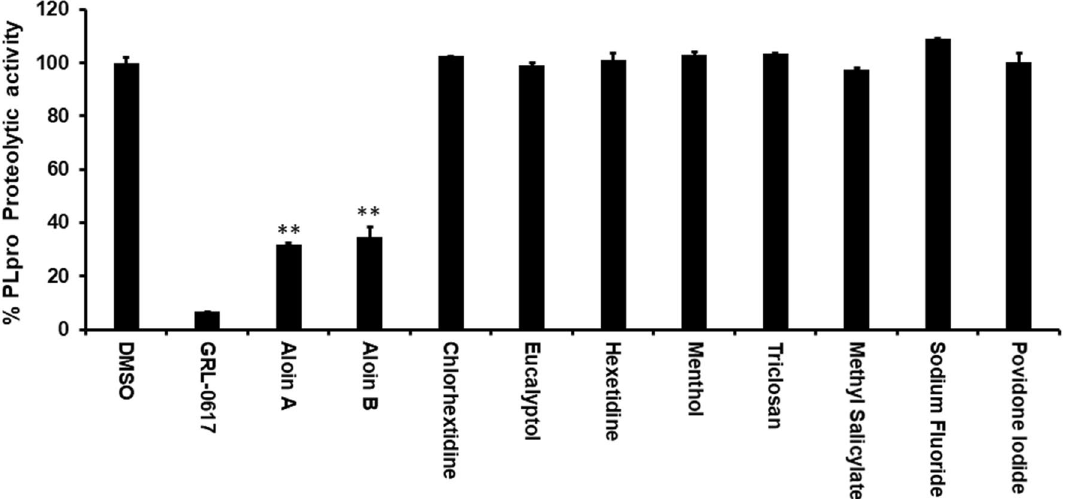
Figure 3. Aloin A and B specifically inhibits the SARS-CoV-2 PLpro proteolytic activity. Aloin A, aloin B, chlorhextidine, ecalyptol, hexetidine, menthol, triclosan, methyl salicylate, sodium fluoride and providone iodide were selected for their inhibitory activity against SARS-CoV-2 PLpro enzyme as described under Materials and Methods. The fluorescence intensity was used to calculate the percent enzymatic activity considering DMSO treated control as 100% activity. Blank values were subtracted before calculating the percent activity. DMSO (0.1%) with enzyme and 50 µM of substrate served as positive control. Wells with 50 µM of GR-L0617 compounds served as specificity controls for PLpro. Representative of three experiments (n = 3) with triplicate values were presented graphically. P value < 0.001 considered as statistically significant. One-way ANOVA with Bonferroni’s Multiple Comparison post-hoc test was used to calculate the statistical